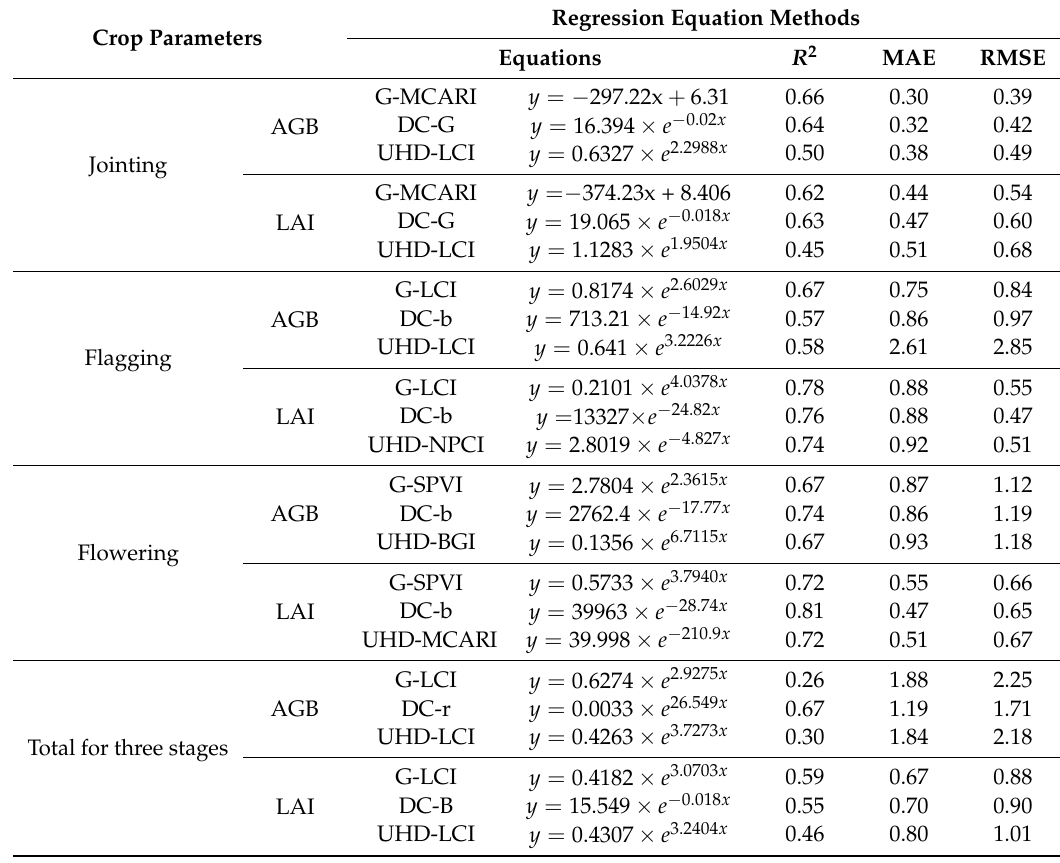
Total for three